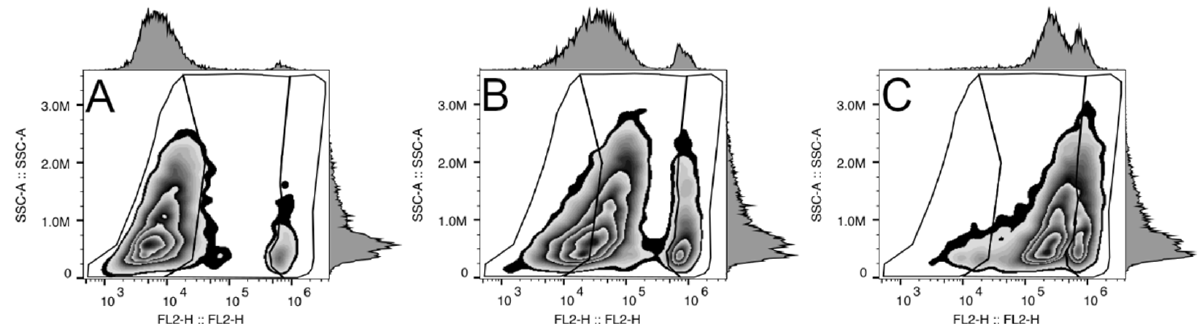
Figure 1. Gating strategy for the determination of successful PI electrotransfer and dead cells. ( A ) represents control cells (not treated with electric fields); ( B , C ) represents cells electroporated with one 100 µ s-duration pulse at 800 V/cm and 1400 V/cm electric field strength, respectively. The Y axes show side scatter, and the X axes show the values of FL-2 channel (excitation 488 nm, emission 585/40 nm) fluorescence values. Three segments are marked: leftmost: viable cells, middle: PI-positive viable cells, rightmost: PI-positive dead cells.